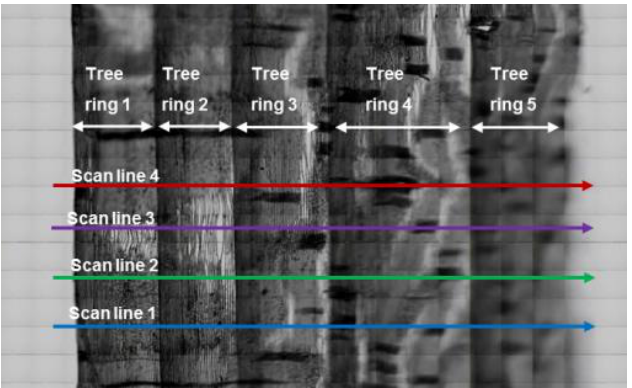
Figure 1. Visual survey image of Norway spruce subsample with colored arrows showing the principle spatial position of the four scan lines recorded on each of the investigated subsamples.